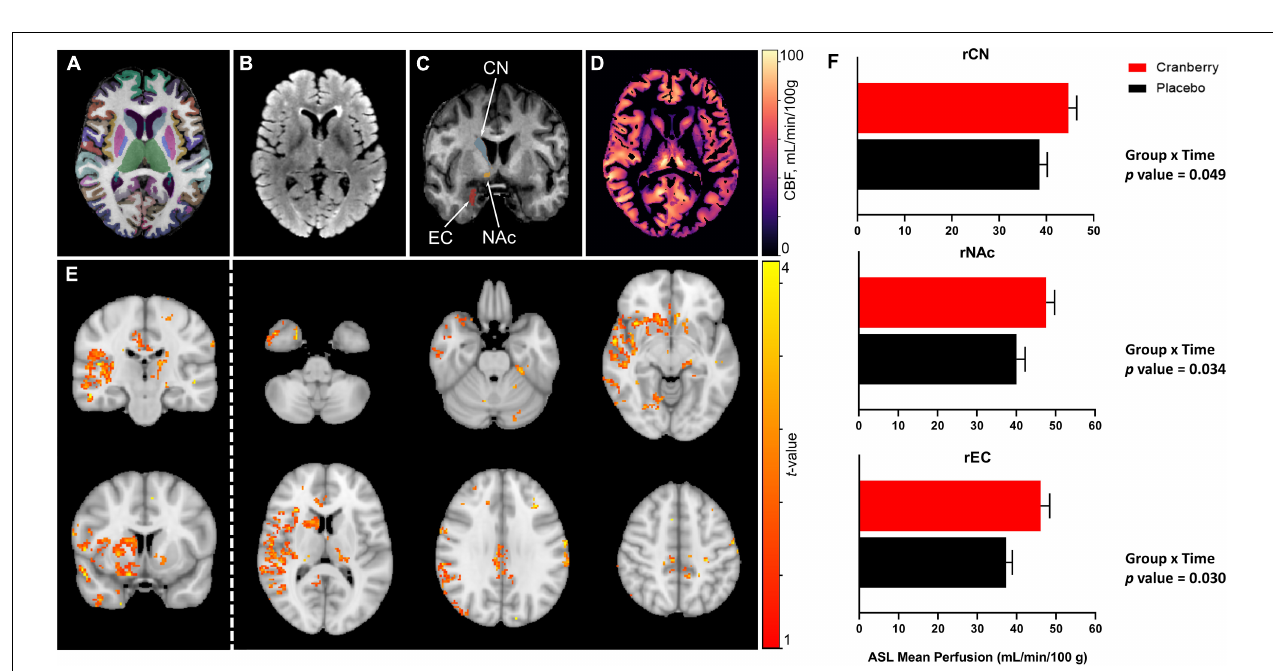
FIGURE 2 | Representative magnetic resonance imaging data following 12-week consumption of a cranberry extract or a placebo. (A) Axial view of FastSurfer cortical and subcortical segmentations superimposed on a T1-weighted image; (B) axial T2-weighted fluid attenuated inversion recovery (FLAIR) image; (C) a coronal view of the T1-weighted image indicating regions that showed significantly increased perfusion after 12 weeks consumption of a cranberry extract—namely, from superior to inferior, the right caudate nucleus, accumbens area, and entorhinal cortex; (D) an axial cerebral blood flow (CBF) map, in the T1 space, derived from arterial spin labelling data; (E) t -value maps overlaid on a standard brain show trends to increased perfusion in the cranberry group as compared to the placebo group, in similar regions to those indicated in the ROI-wise analyses; and (F) differences in mean blood perfusion for the right caudate nucleus (rCN), right nucleus accumbens (rNAc), and right entorhinal cortex (rEC), with p -values represented for group × time interaction effects between cranberry and placebo groups from baseline to follow-up.